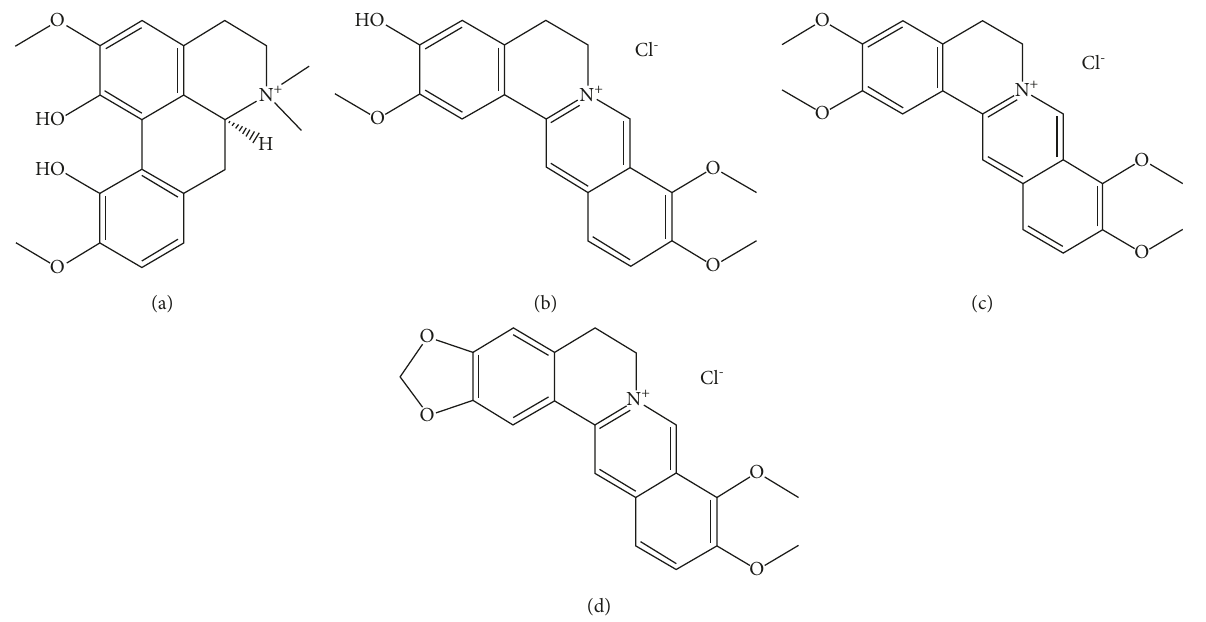
Figure 1: The chemical structure of four alkaloid compounds. (a) Magnoflorine; (b) jatrorrhizine hydrochloride; (c) palmatine hydro- chloride; (d) berberine